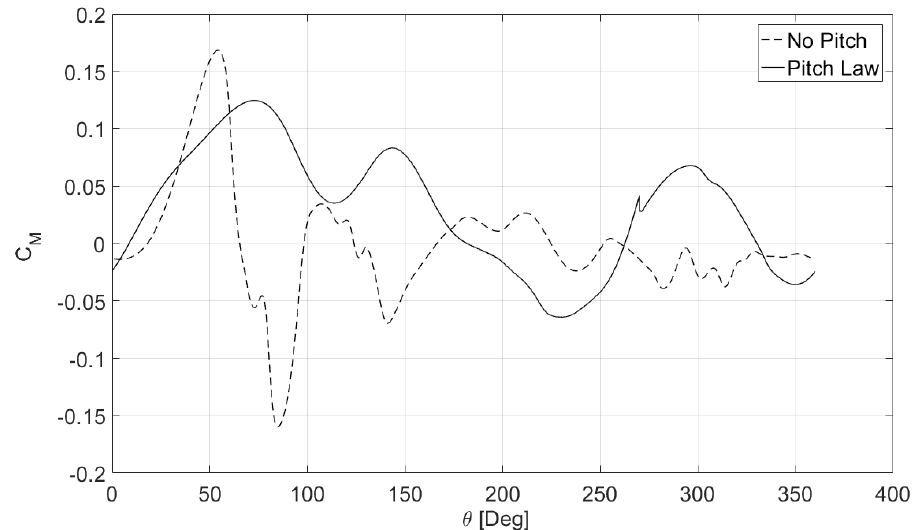
Figure 14. Instantaneous torque coefficient versus azimuthal position: case without pitch law (Case 0) and with pitch law (Case